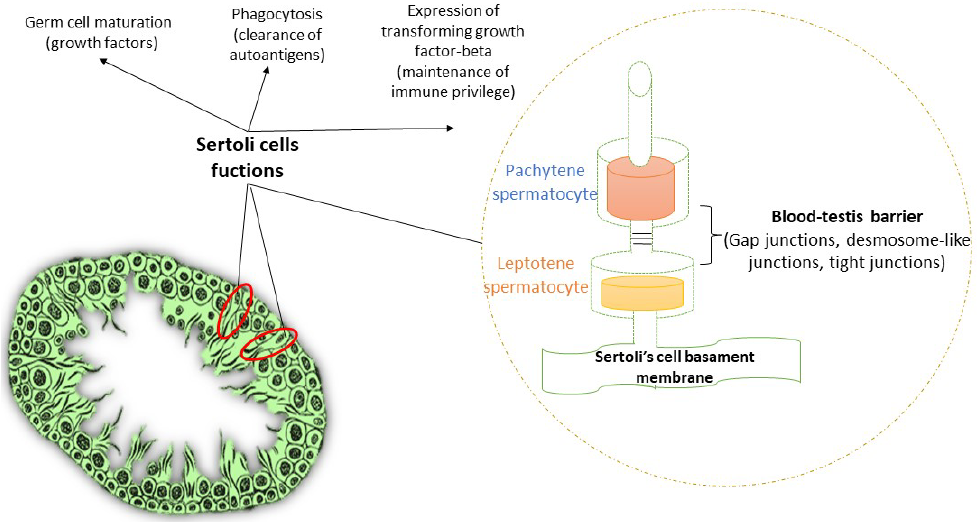
Figure 2. Blood–testis barrier composition. The blood–testis barrier, besides in gap junctions, desmosome-like junctions and tight junctions, has Sertoli cells (SCs). SCs participate in the nutrition and growth of germ cells, maintenance of the immune privilege and clearance of autoantigens and apoptotic cells via phagocytosis.